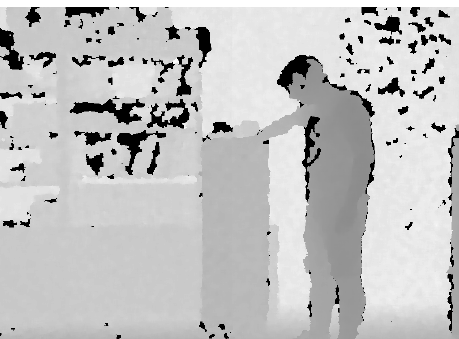
Figure 1. Example of imperfections in a Kinect depth map: Original depth map with hole pixels (represented as black pixels) detected by the ―non-available‖ tags.